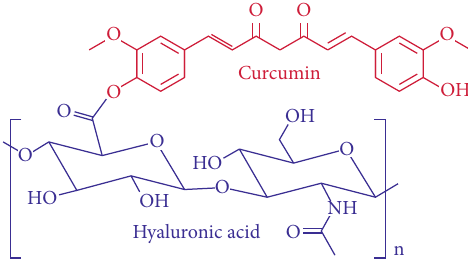
Figure 2: Hyaluronic acid-curcumin conjugate.